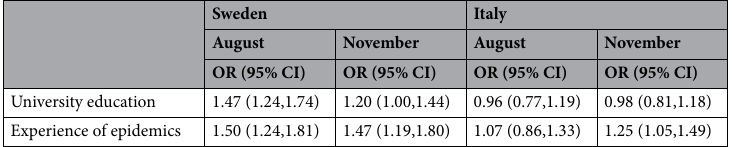
Table 2. Factors associated with epidemic risk perception by country and period.